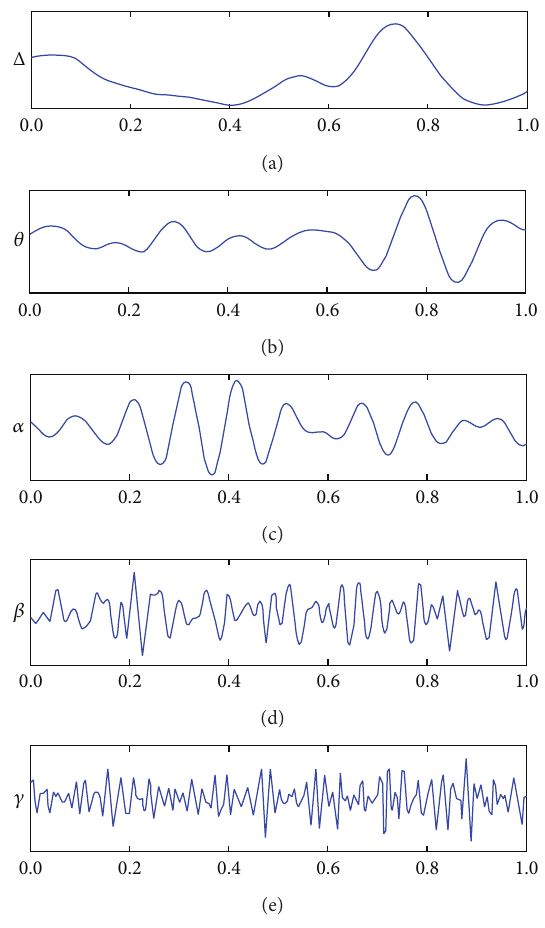
Figure 3: Brain waves in 5 main frequency bands